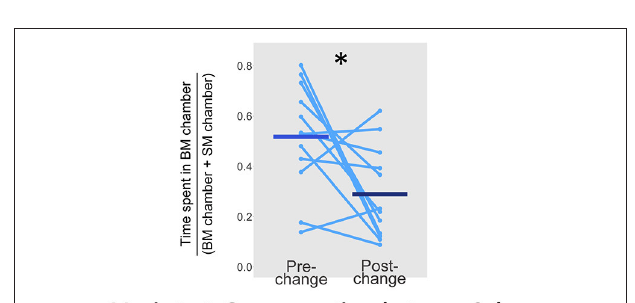
FIGURE 5 | Results of the time spent in front of each monitor including attentional behaviors in the Movie test over 2days ( N = 12). (A) The time spent in front of the monitors. (B) Percentage of duration spent in front of the monitors during the entire time in each chamber. Gray dots and lines indicate the individual data, and horizontal colored bars show the averaged time in each condition, respectively.